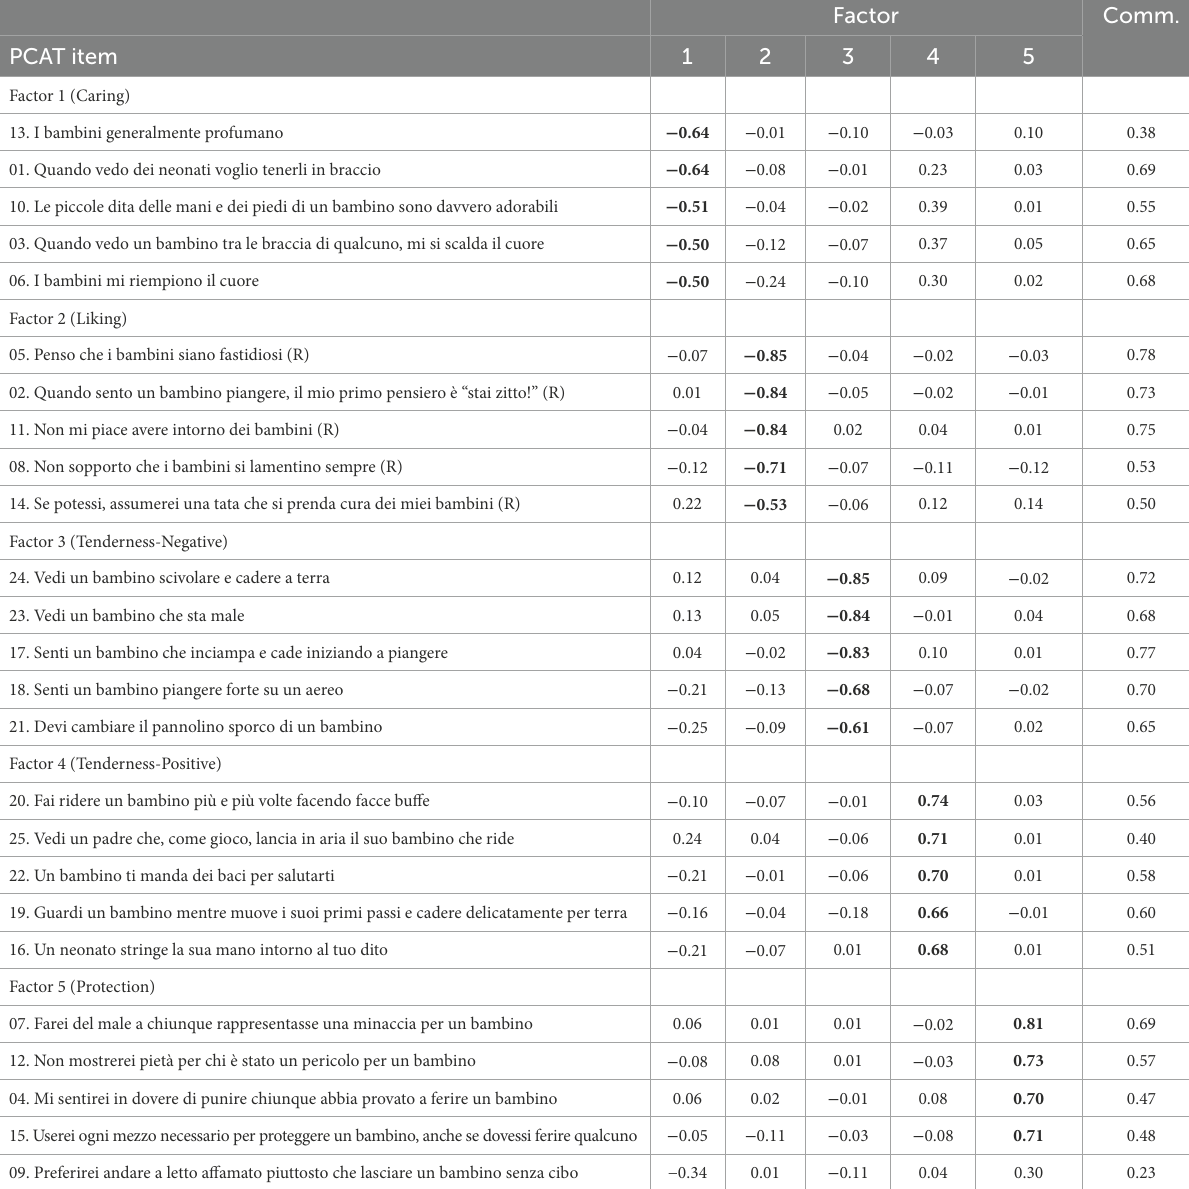
TABLE 1 The Italian translation of the 25 items of the PCAT.